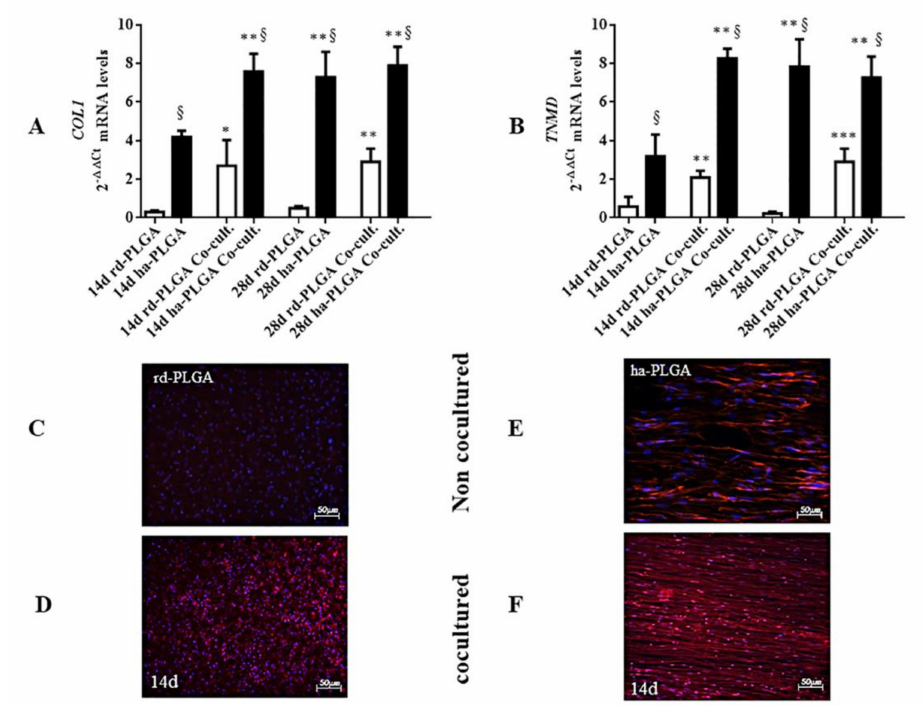
Figure 8. oAEC tenogenic di ff erentiation analysis in electrospun PLGA fleeces after using the normal or co-culture system with fetal tendon explants after 14 and 28 days. Quantitative RT-PCR for ( A ) COL1 and ( B ) TNMD mRNA expression showing that oAECs seeded onto ha-PLGA already at 14-day co-culture highly produce the two tenogenic markers with values that are comparable to the corresponding 28-day normal condition cultured cells. Co-cultured oAEC-rd-PLGA fleeces started to express COL1 and TNMD from day 14. * p < 0.01 di ff erent values in the same fleece type. ** p < 0.001 di ff erent values in the same fleece type. *** p < 0.0001 di ff erent values in the same fleece type. § p < 0.01 di ff erent values between di ff erent fleeces in each time culture. ( C , D ) IHC shows that in rd-PLGA fleeces, after 14 days culture, oAECs start to faintly express COL1 in their cytoplasm in co-culturing conditions. Scale bars = 50 µ m. ( E , F ) At day 14 positivity to COL1 was evident in the cytoplasm in the normal cultural condition, whereas in the co-culturing condition oAECs secreted the protein also in the fleece. Scale bars = 50 µ m. (n = 3 for each type of sample / analysis / time point, sca ff old size: 15 mm × 7